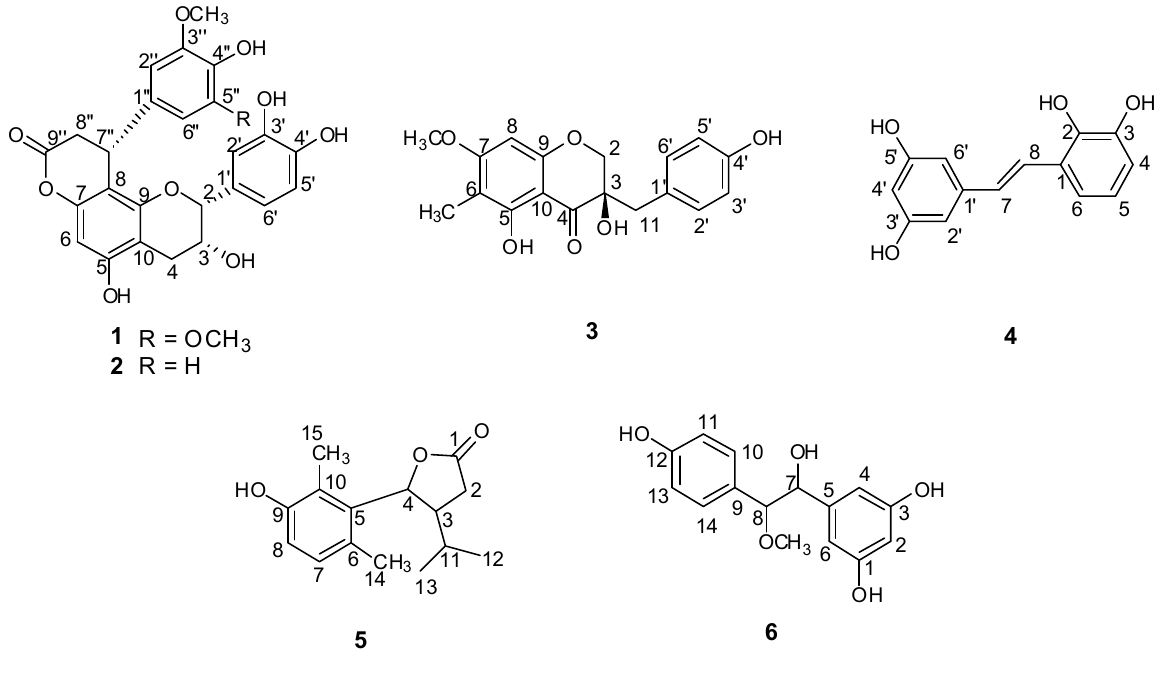
Figure 1. Chemical structures of compounds 1 – 6 .